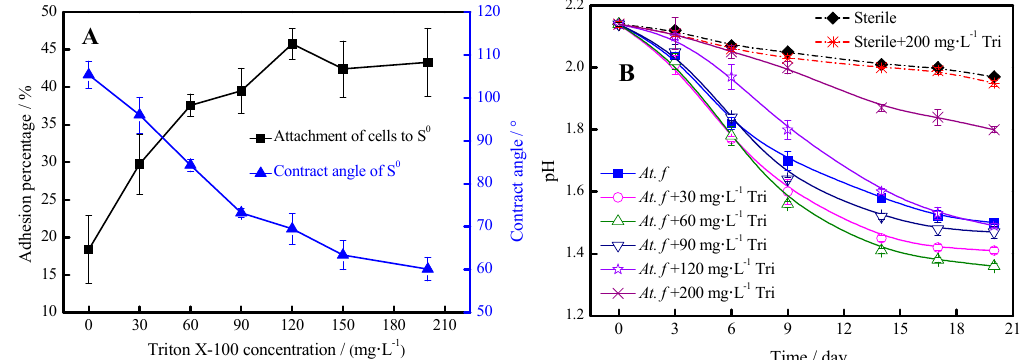
Figure 3. Influences of Triton X-100 on contact angle of S 0 and bacterial attachment to S 0 , as well as on the oxidation of S 0 : ( A ) S 0 1% ( w / v ), bacteria inoculation 5 × 10 7 cells · mL − 1 , temperature 30 °C, and adsorption time 30 min; ( B ) S 0 1% ( w / v ), bacteria inoculation 10% ( v / v ), initial pH 2.1, and temperature 30 °C.